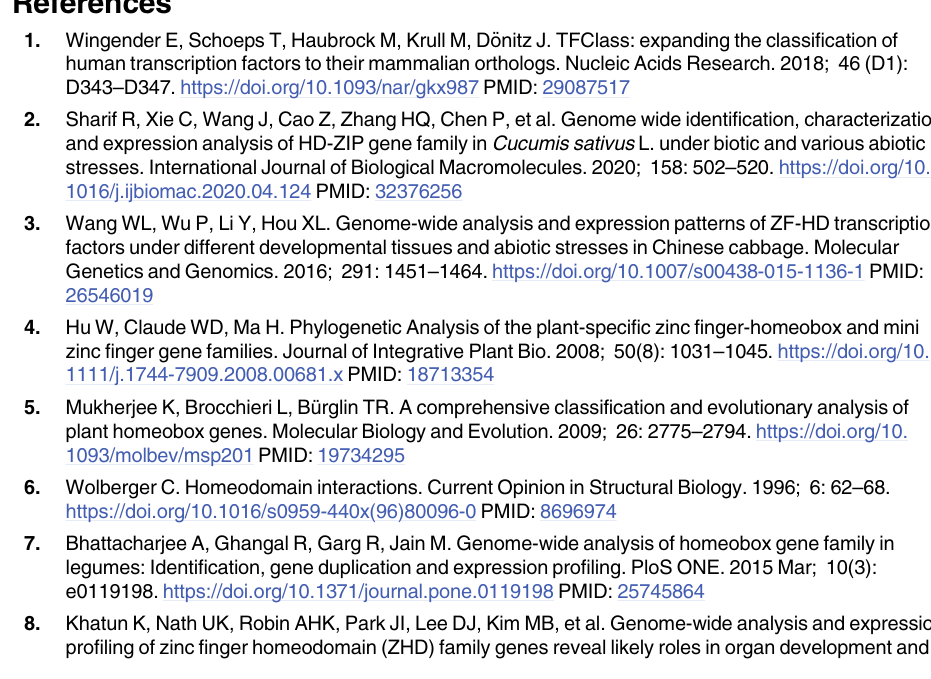
S9 Table. BLASTp search